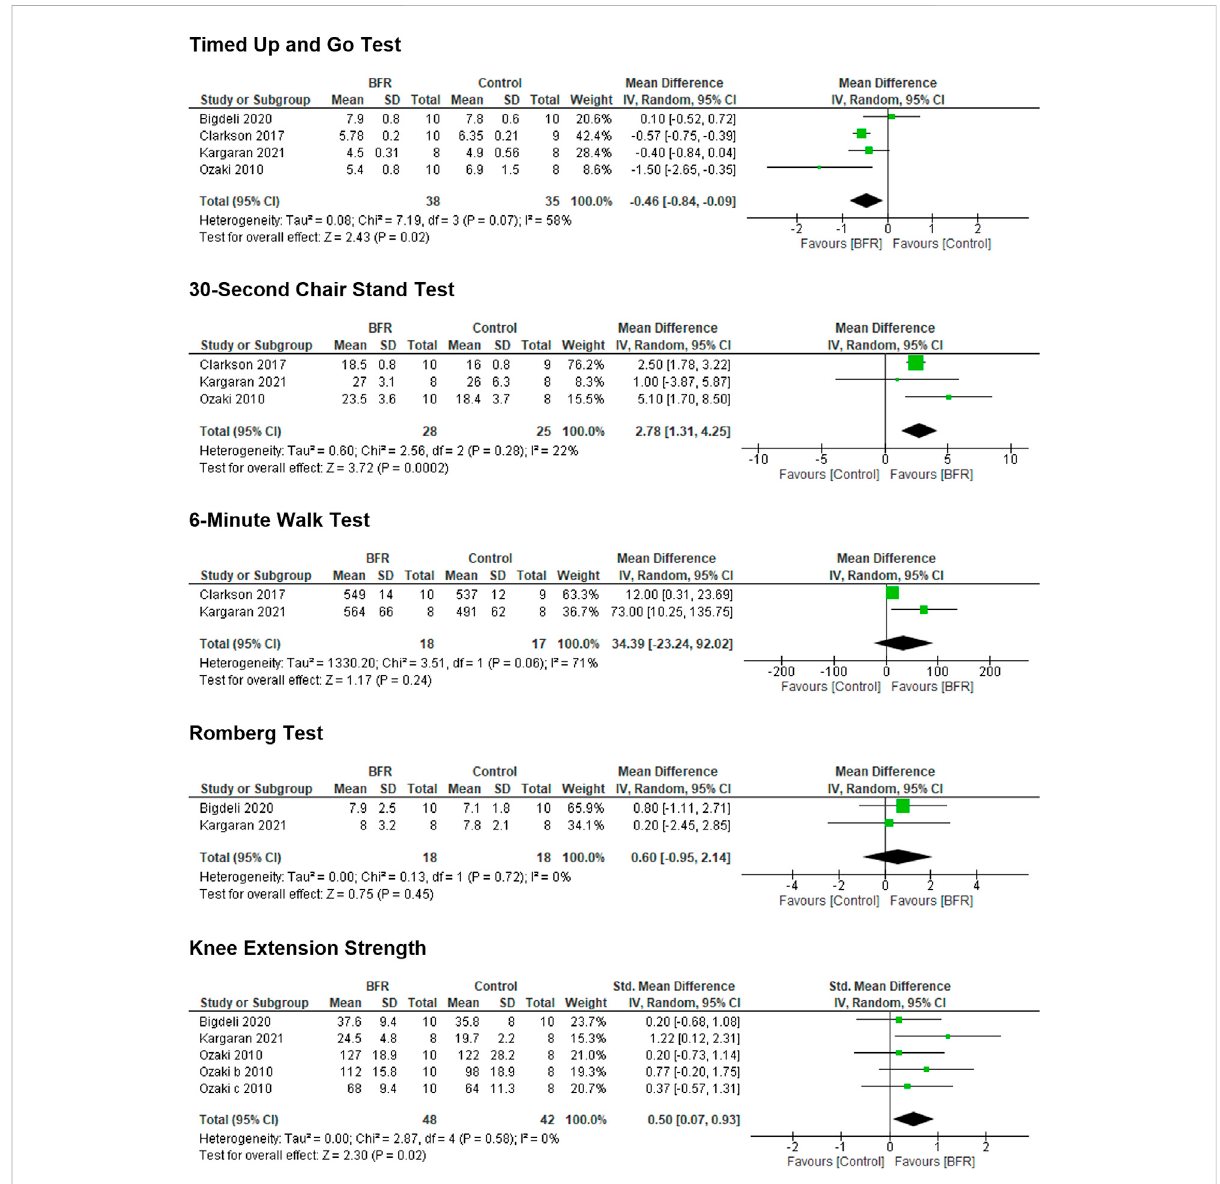
FIGURE 3 Forest plots showing the effects of blood fl ow restriction training on different functional performance measures in older